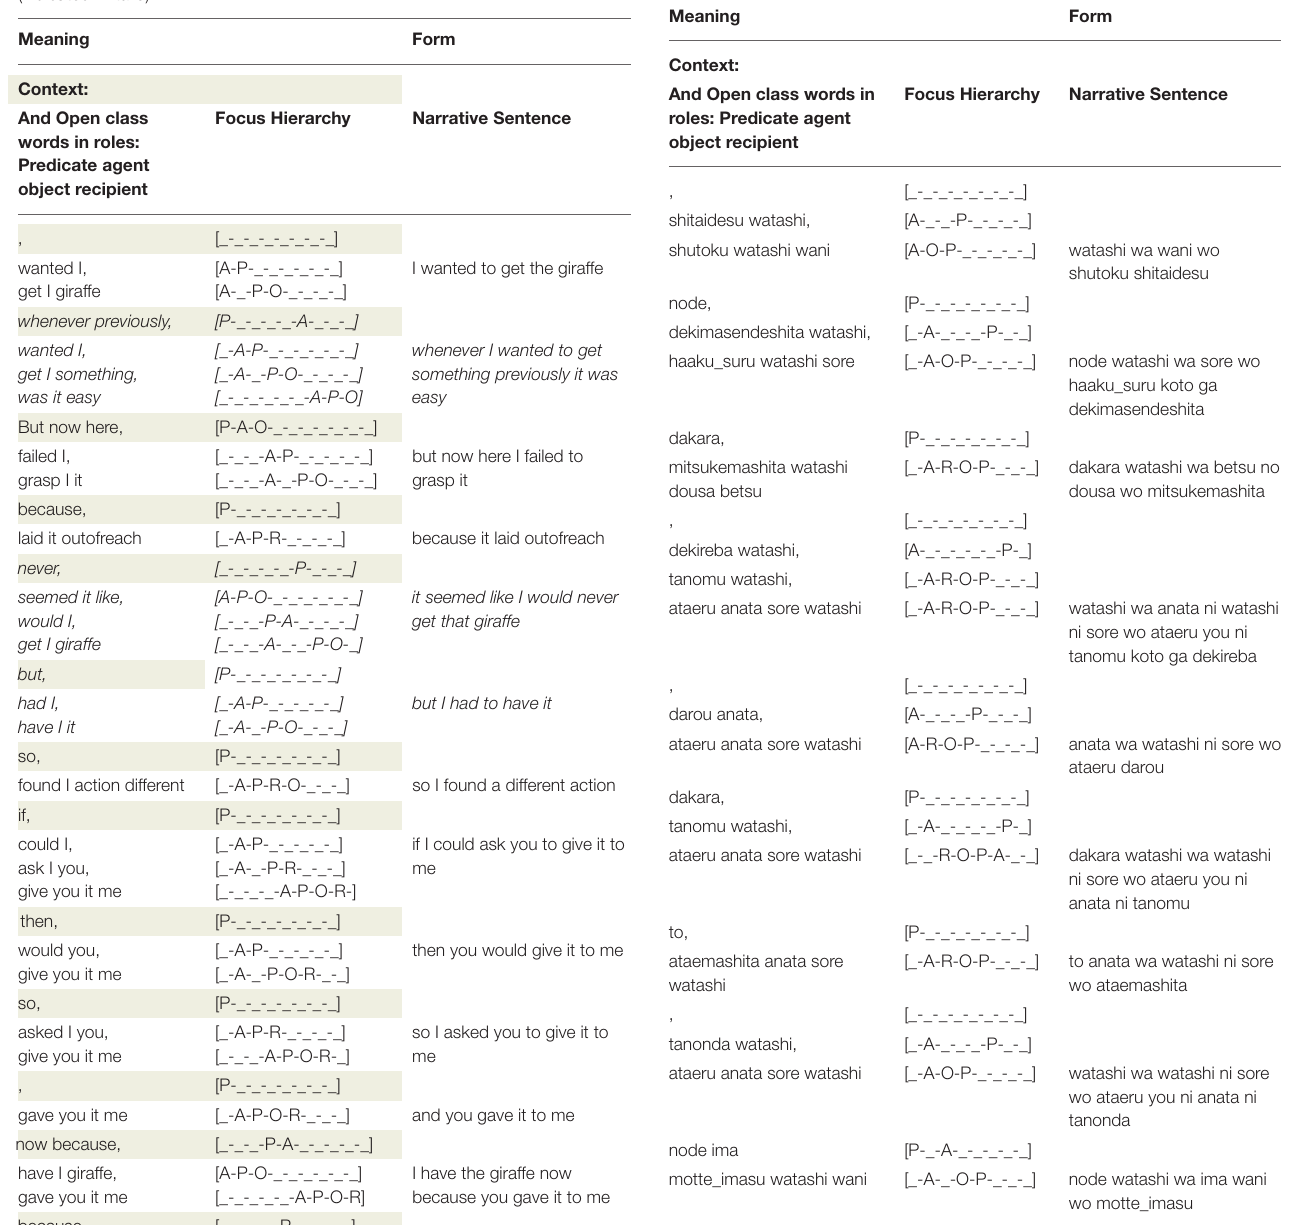
Simulation Tests 5 and 6 —A Japanese training corpus ( Table 10 ) was first generated by hand and used to validate that the narrative production and comprehension models were capable of learning this corpus. The meaning of these sentences is clarified in Table 11 . The NCx comprehension and production models, each with 800 neurons, were trained and tested on this corpus. In Simulation Test 5, the comprehension model successfully generated the meanings and narrative links from the narrative, and in Simulation Test 6, the production model successfully generated the narrative from the meanings